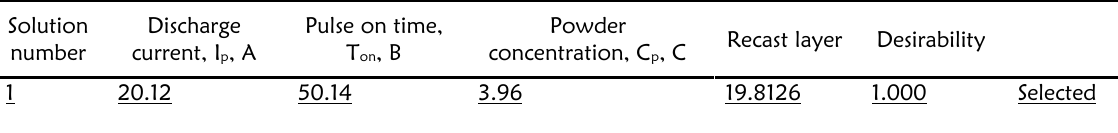
Table 7: Solution for